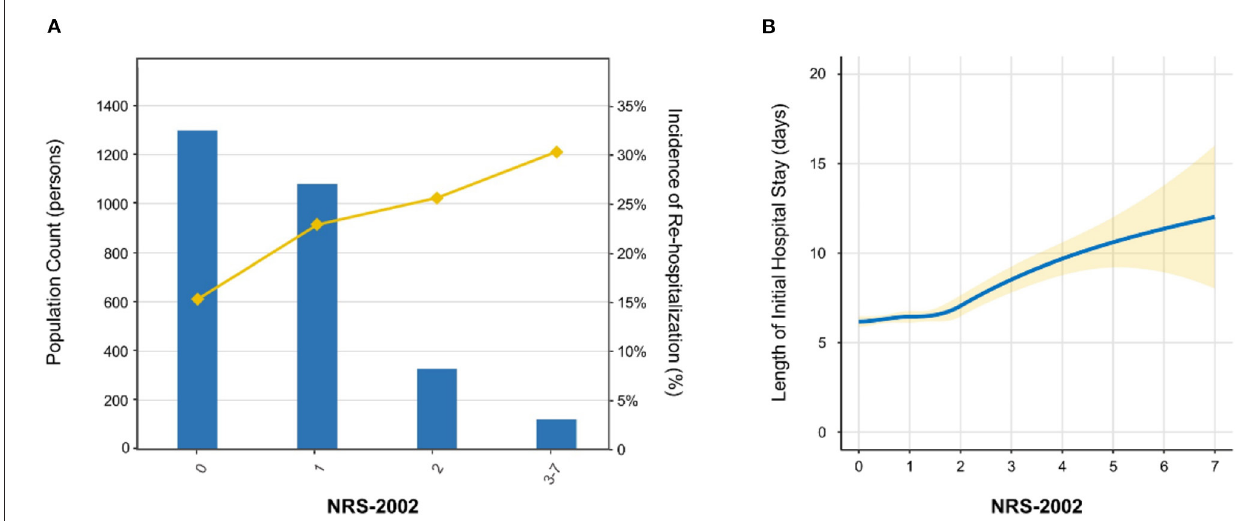
FIGURE 2 | Population distribution and loess smooth curve. (A) The distribution of study population and the incidence of re-hospitalization. The histogram showed the population distribution of study subjects stratified by NRS-2002 categories, while the line chart showed the trend of incidence of re-hospitalization. (B) Loess smooth curve of NRS-2002 score with the length of initial hospital stay. The loess smooth curve was fitted for exploring the association between NRS-2002 score and the length of initial hospital stay. The yellow shadow around the solid line represents 95% confidence interval. NRS-2002 indicates Nutritional Risk Screening 2002.